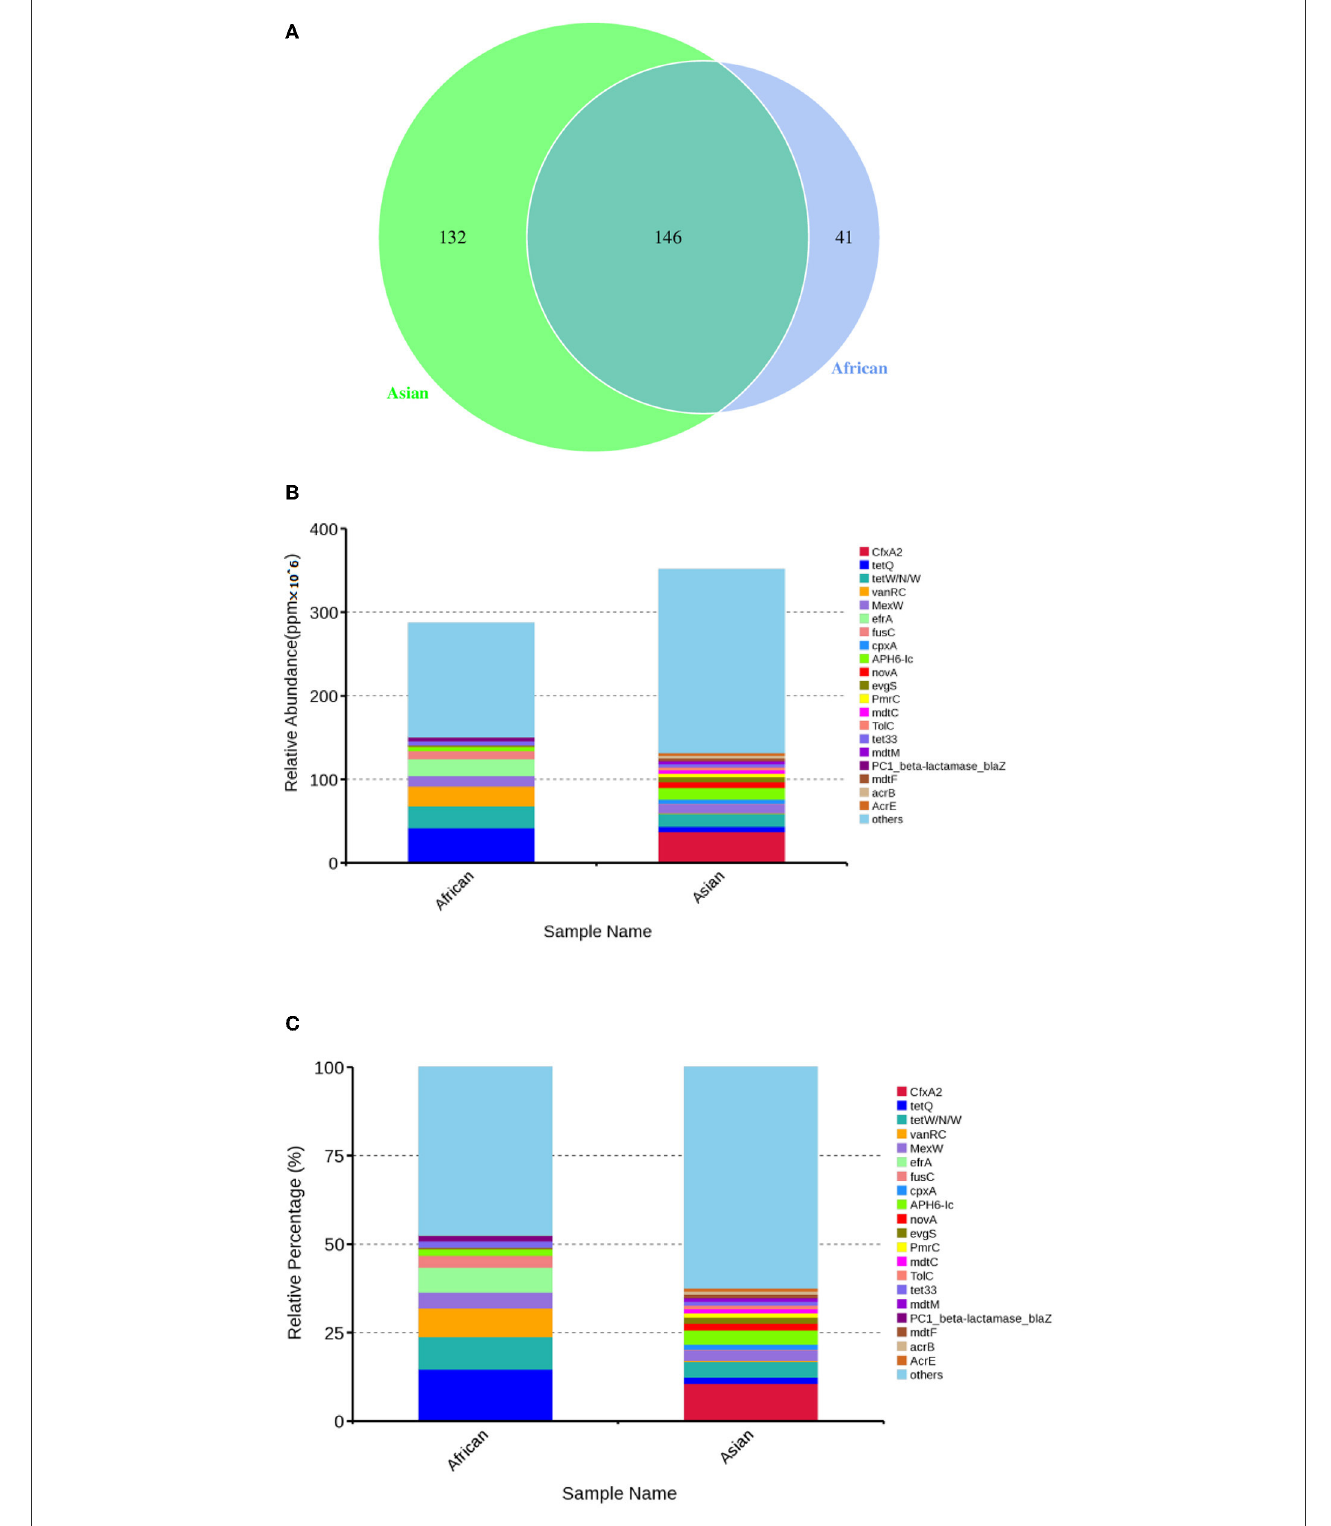
FIGURE7 (A) Venn diagrams of antibiotic resistant genes shared by African and Asian elephants and specific genes belong to each host species; (B) Absolute gene abundance of different ARGs in each sample ( × 10 6 ); (C) Relative abundance of top 20 ARGs.